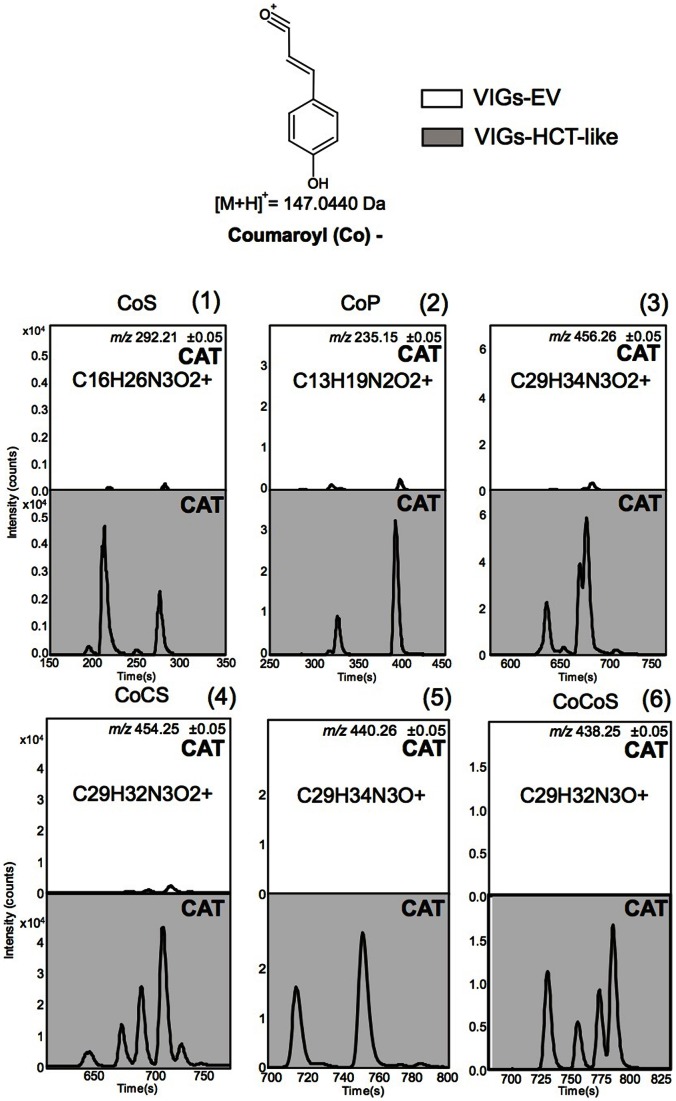
Precursor ions of abundant coumaroyl-containing PAs are up-regulated in response to HCT-LIKE silencing.Representative (n = 5 biological replicates) extracted ion chromatograms (EIC) for precursors of VIGs-HCT-LIKE-specific coumaroyl-based mono-acylated putrescines and mono- and di-acylated spermidines (Table 1). Ion types selected for the calculation of EIC traces correspond to the protonated [M+H]+
m/z signals of the different isomers of (1): N′-coumaroylspermidine (CoS), (2): N- coumaroylputrescine, (3): monhydrated N′,N′′- coumaroyl, caffeoylspermidine, (4): N′,N′′- coumaroyl, caffeoylspermidine (CoCS), (5): monohydrated N′, N′′-di-coumaroylspermidine and (6): N′,N′′-di-coumaroylspermidine (CoCoS). Structural rearrangements during in source ionization and fragmentation did not allow for unequivocal assignment of the phenylpropanoid residues to the different N positions of putrescine and spermidine backbones. CAT: M. sexta caterpillar-attacked leaves.